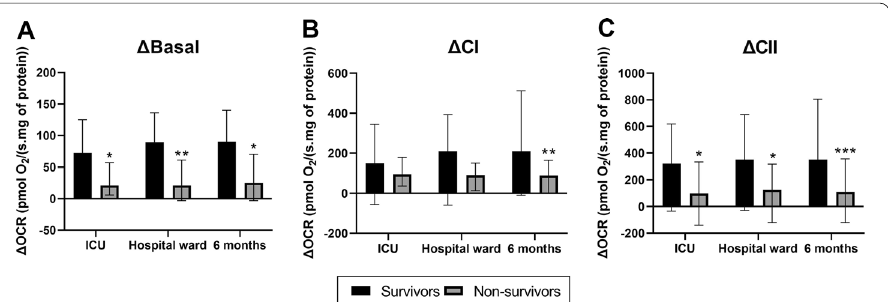
Fig. 2 Mitochondrial bioenergetic function is reduced in lymphocytes of non-surviving septic shock patients. Variations (day 3 minus day 1 admission) in mitochondrial oxygen consumption rates in conditions not stimulated by metabolic substrates ( A , ΔBasal), stimulated by complex I substrates, pyruvate, malate, and glutamate ( B , ΔCI), and stimulated by complex II substrate, succinate ( C , ΔCII). Figures are presented as median IQR. *Indicates significant differences relative to surviving at P < 0.05; ** P < 0.01; and *** P < ±